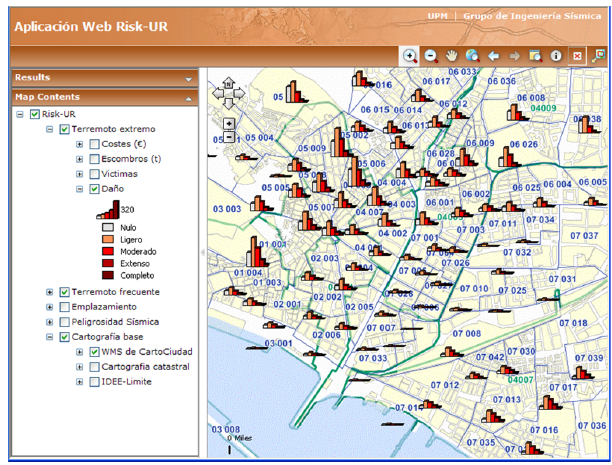
Fig. 9. Web visualiser image showing damage distribution by city sectors with an extreme